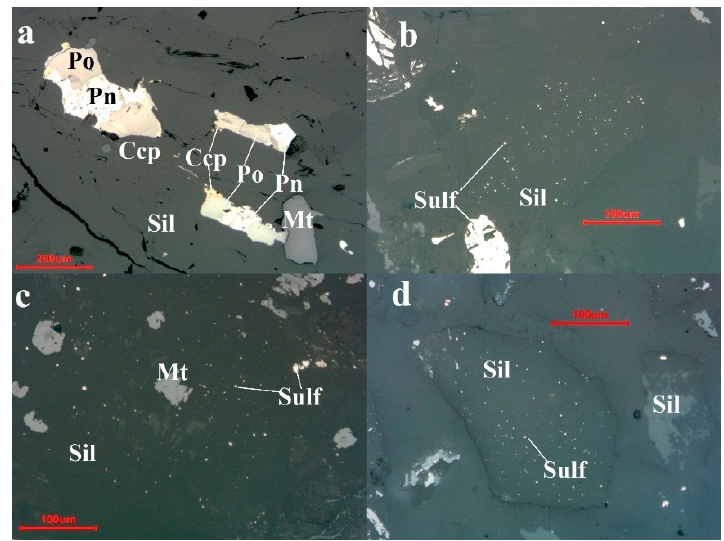
Figure 1. An example of low-grade disseminated sulfide copper-nickel ores of the Murmansk Region: ( a ) Large intergrowths of several sulfides and magnetite in a silicate; ( b – d ) large intergrowths of sulfides and finely disseminated sulfides in silicate. Images taken with reflected polarized light. Ccp: chalcopyrite; Mt: magnetite; Pn: pentlandite; Po: pyrrhotite; Sil: silicate mineral; Sulf: sulfide.